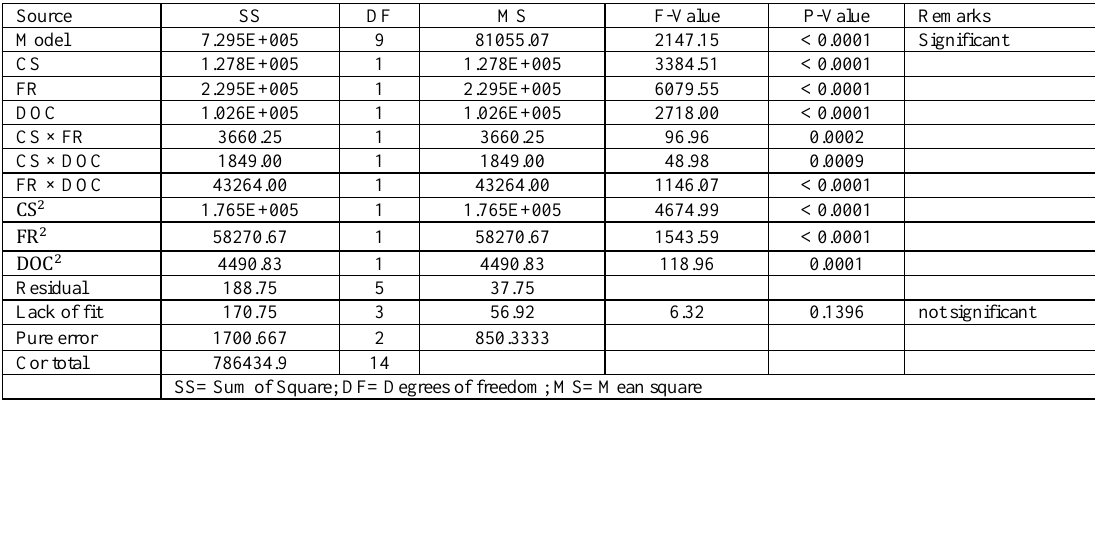
Table 4. ANOVA for main cutting force